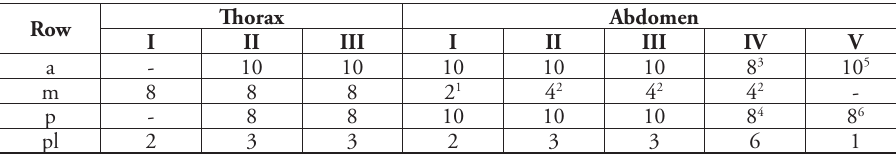
Table 1. Dorsal Chaetotaxy of Metaphorura motuoensis sp.